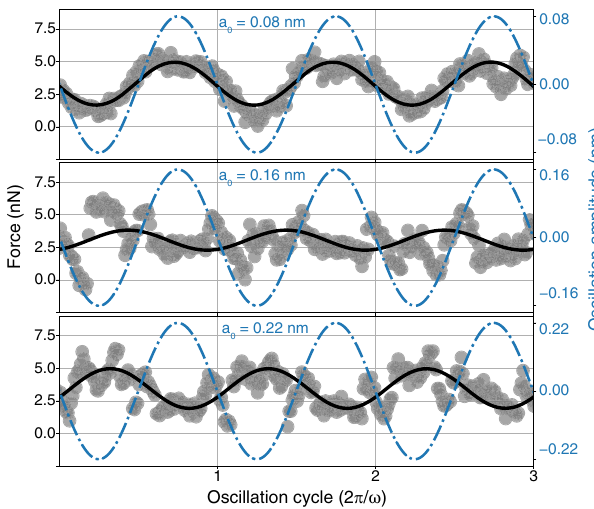
Fig. 2 Force time evolution under oscillating strain. Time-dependent force results for the N ≈ 9 nanojunction of Fig. 1b with equilibrated shape, initial h ≈ 2.75 nm, relaxed neck length d ≈ 1 nm, average neck cross section 0 0 area A ≈ 0.6 nm 2 , oscillation frequency 50 MHz, T = 300 K. Blue dashed- dotted line: imposed lead-lead oscillating amplitude a ( t ). Large gray dots: extracted instantaneous force between the leads. Black solid line: sinusoidal fi t F ð t Þ ¼ F þ ð A σ Þ exp ð i ω t þ i ϕ Þ of the force. The fi t parameter A σ 0 is the 0 0 resulting force magnitude. Note the change of rheological response with (cid:2) 0 : 16 nm. Note drastic increase of non-sinusoidal noise at and above a (cid:3) 0 also the prevalence of tensile (positive) force for all strains (see text). The same plot for the largest size of N ≈ 26 is shown on Supplementary Fig. 1.